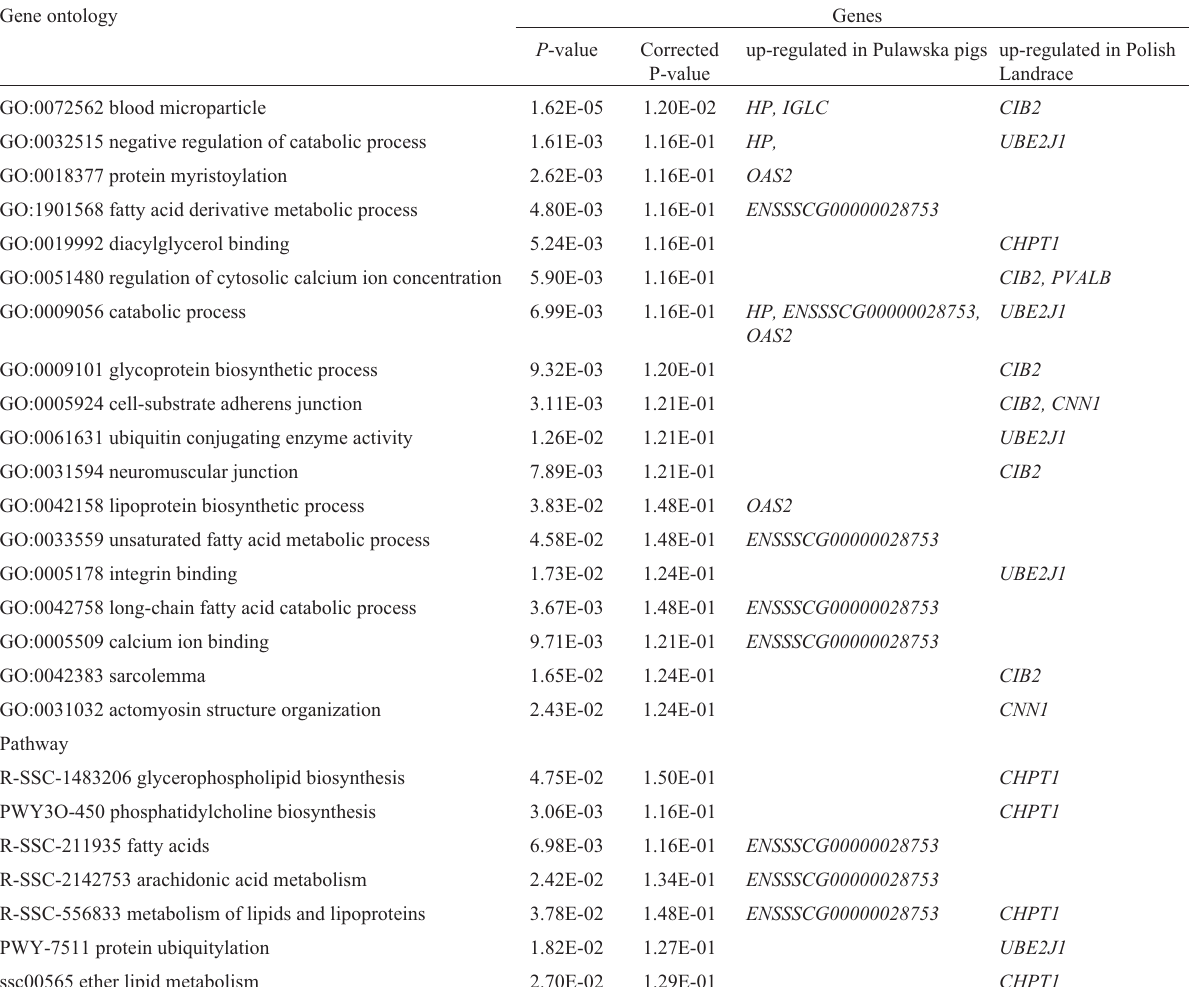
Table 3 - Functional annotation of differentially expressed genes in longissimus dorsi muscle of pigs. Gene